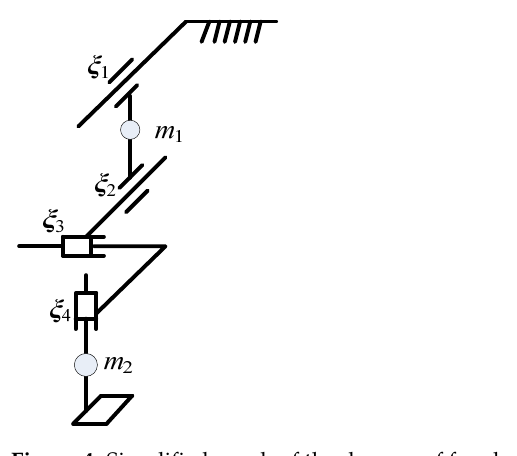
Figure 4. Simplified graph of the degrees of freedom in sagittal